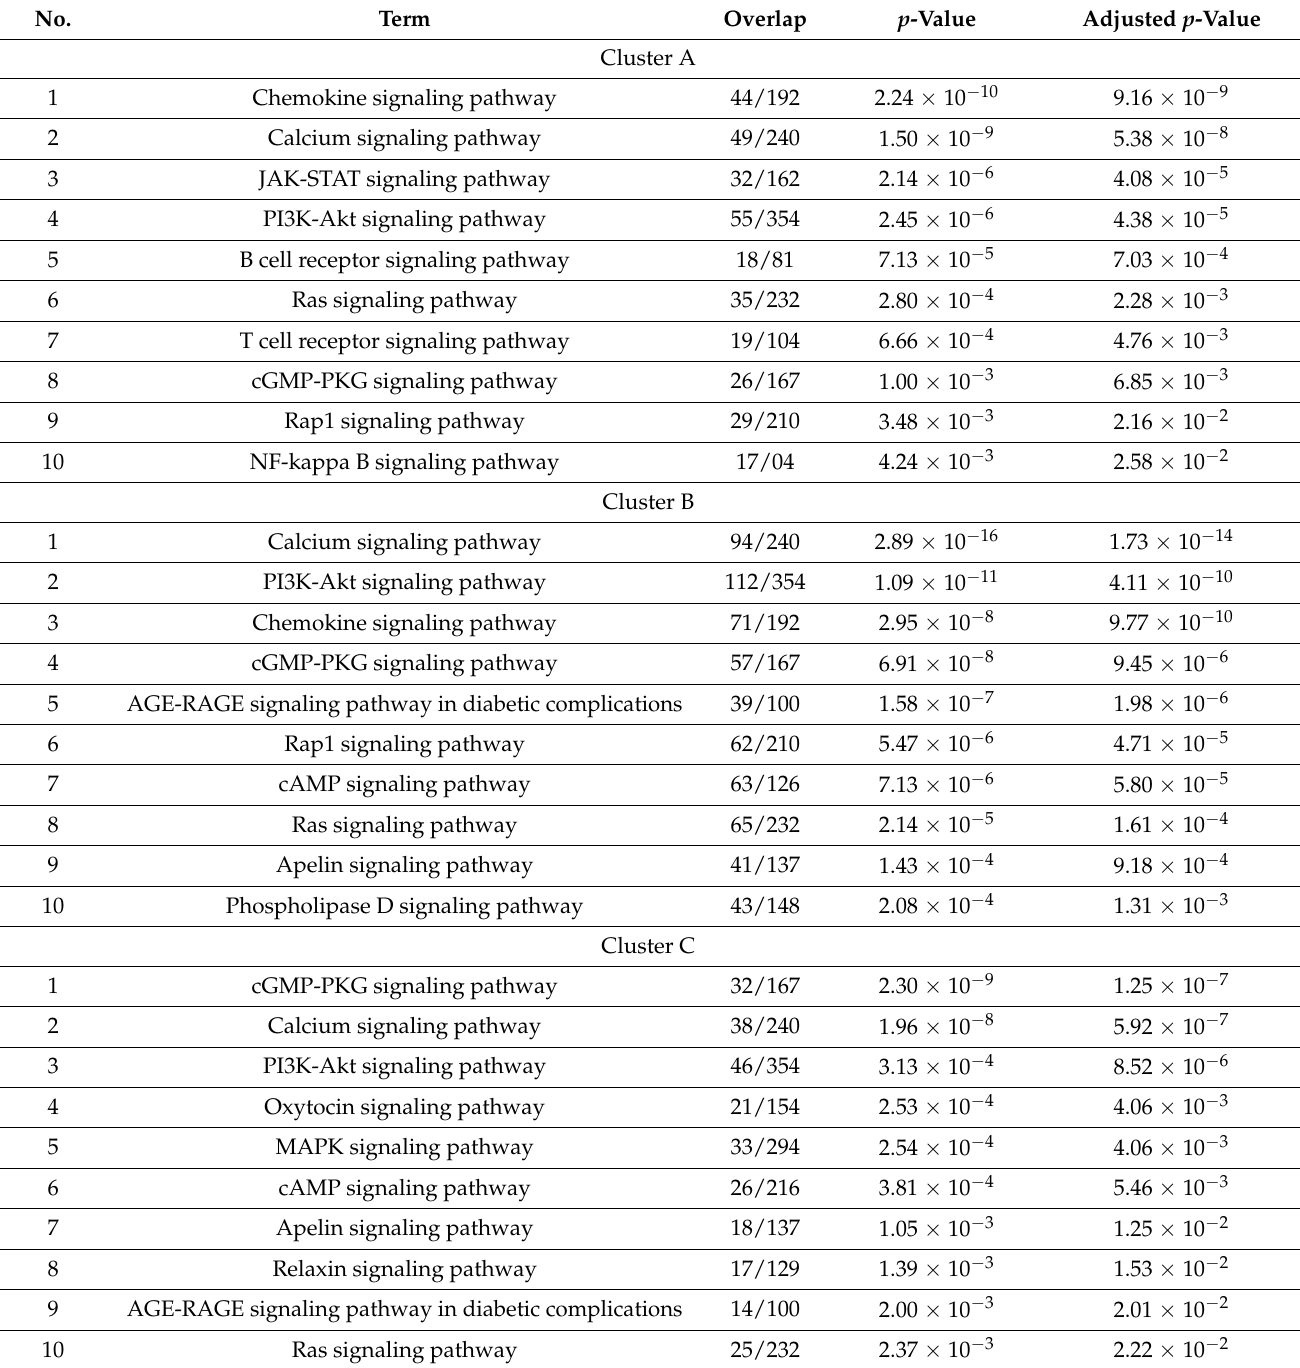
Table 4. The top 10 significantly enriched terms in the KEGG enrichment analysis in each